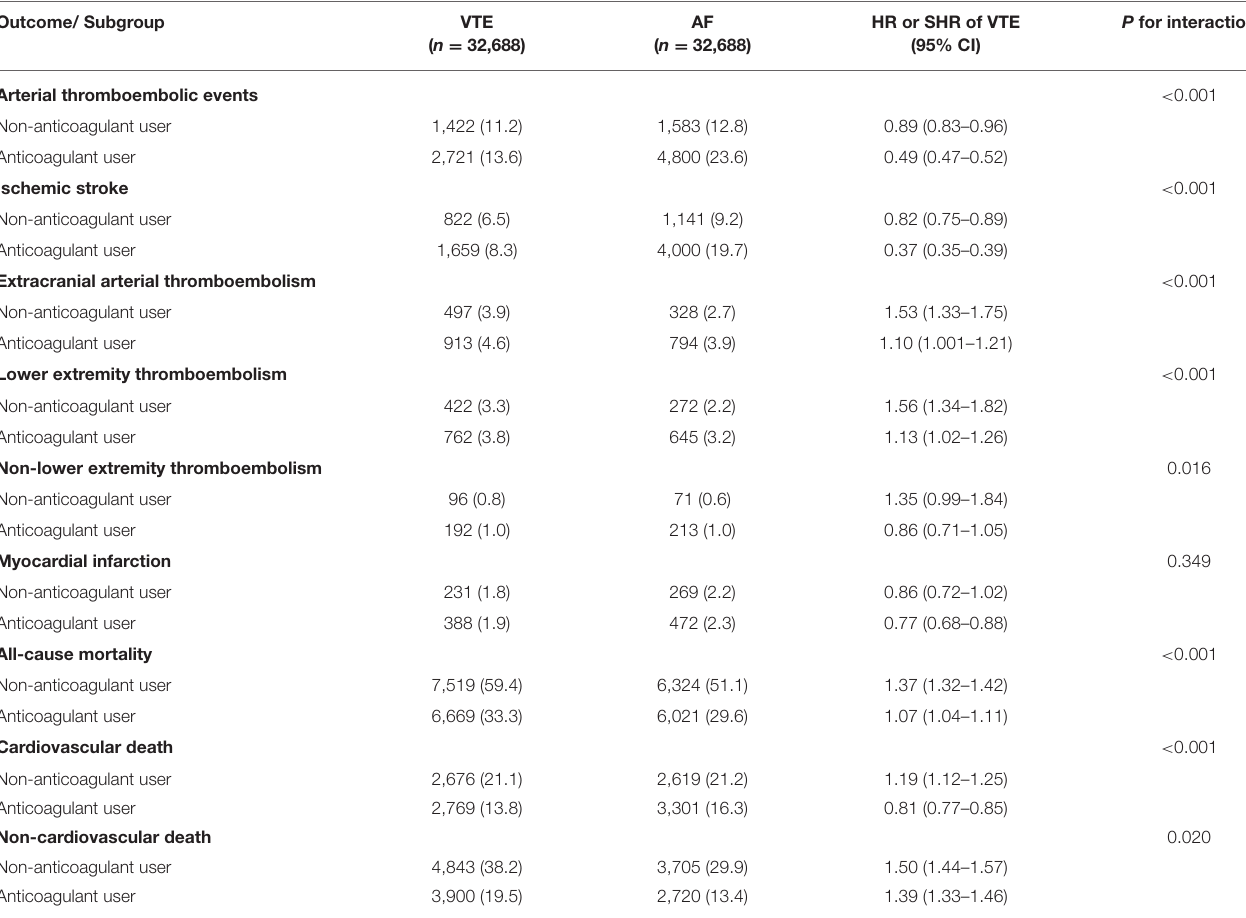
P for interaction AF HR or SHR of VTE ( n = 32,688) ( n = 32,688) (95% CI)